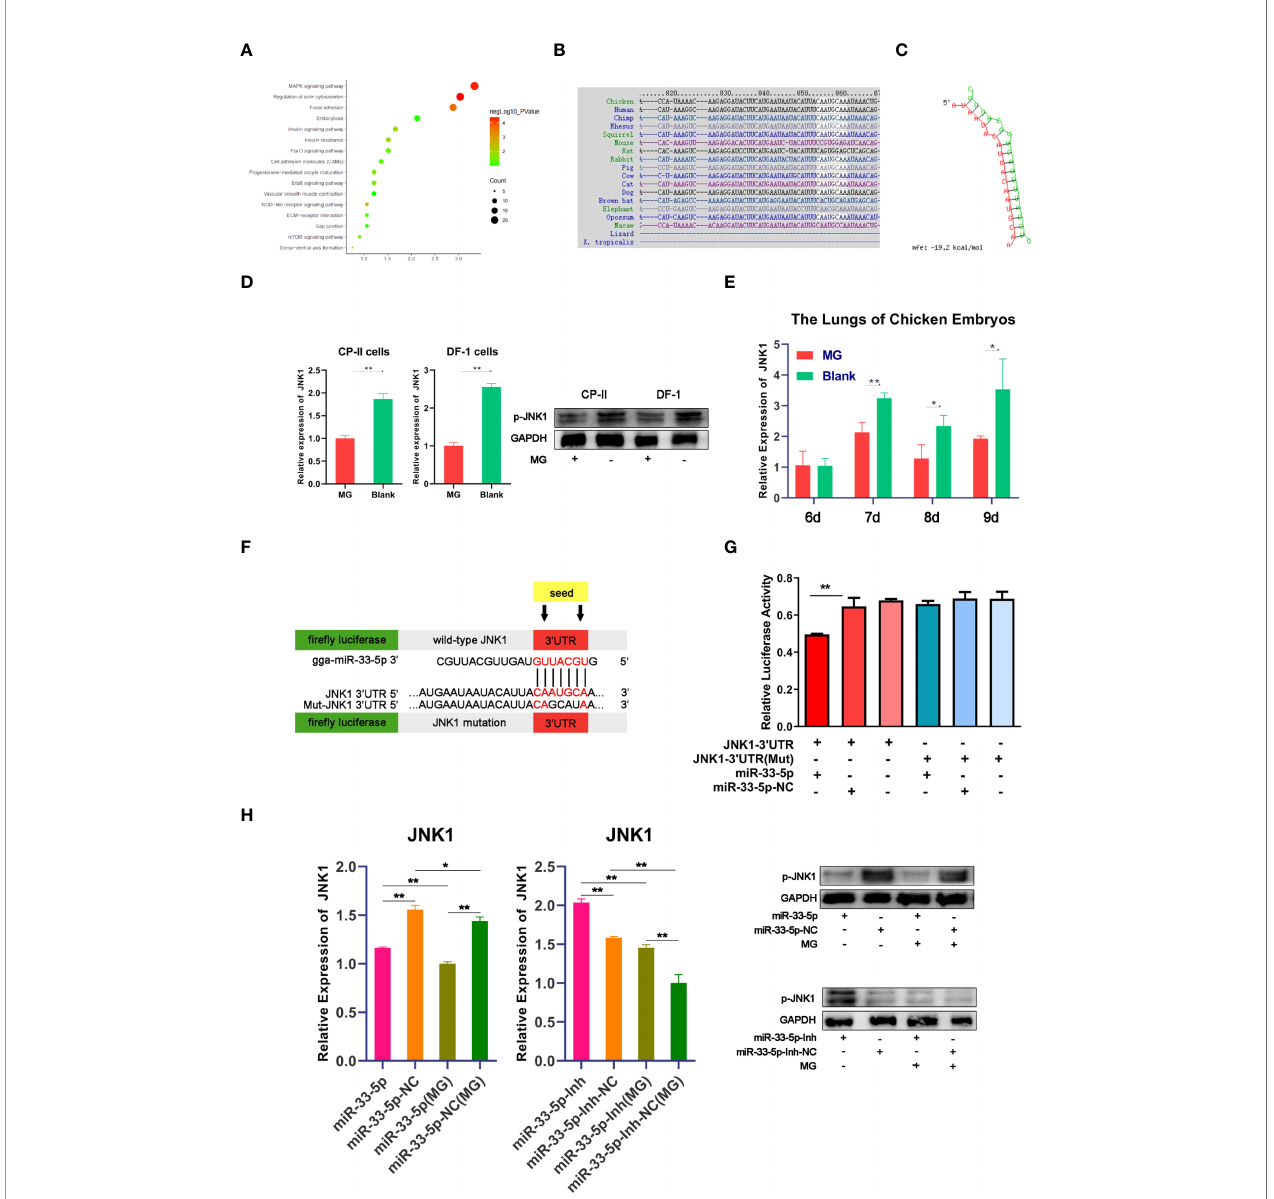
FIGURE 4 | miR-33-5p negatively regulates JNK1 in DF-1 cells. (A) The KEGG enrichment result of target genes of miR-33-5p; (B) Alignment of JNK1 3 ′ UTR in different species; (C) The secondary structure of the RNA duplex of miR-33-5p and the JNK1 3 ’ UTR target site; (D) The JNK1 expression was detected by qPCR and Western blot in MG-infected DF-1 cells and CP-II cells, GAPDH was used as the internal control; (E) The relative expression level of JNK1 in chicken embryo lungs from chicken embryo lungs on days 6-9 post-infection (equivalent to days 15-18 of eggs hatching) using qPCR, GAPDH was used as the internal control; (F) psiCHECK-2 dual- luciferase reporter vector containing the 3 ′ UTR (wild-type or mutant) of JNK1; (G) DF-1 cells were co-transfected with Luc-JNK1 3 ′ UTR (wild-type or mutant) and miR- 33-5p mimics. At 24h post-transfection, the cells were assayed for both fi re fl y and renilla activity through a dual-luciferase glow assay; (H) The mRNA and protein expression of JNK1 after treatment with miR-33-5p mimic/miR-33-5p inhibitor, GAPDH was used as the internal control. (* p < 0.05, ** p <